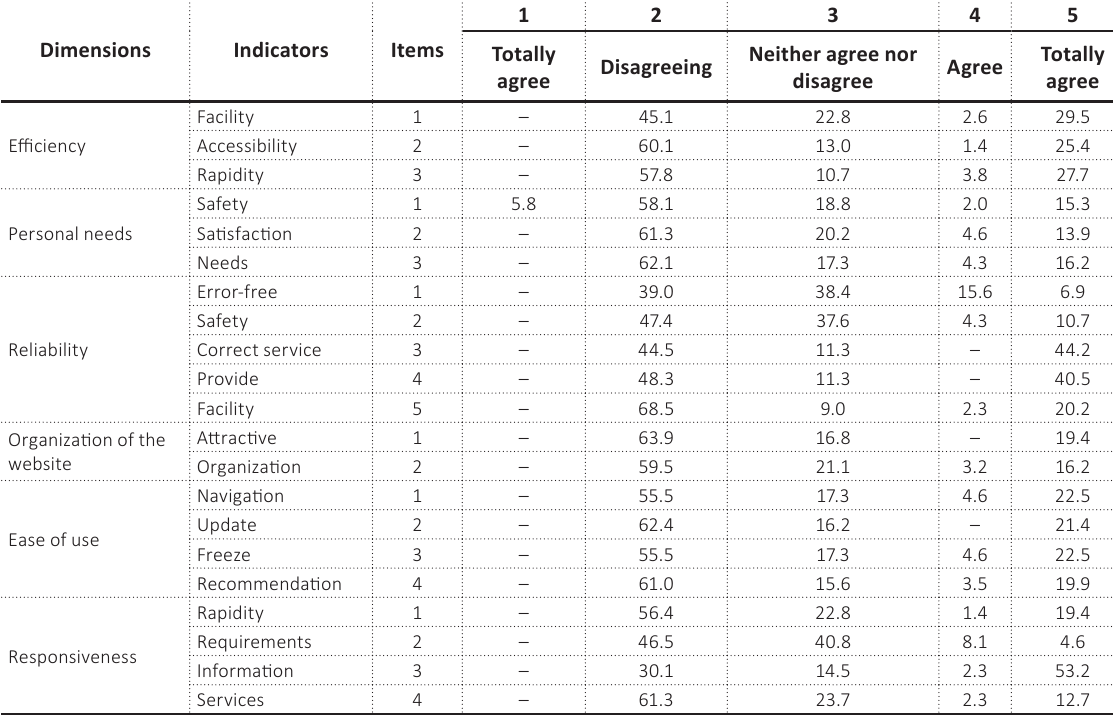
Table 3. Descriptive analysis of variables